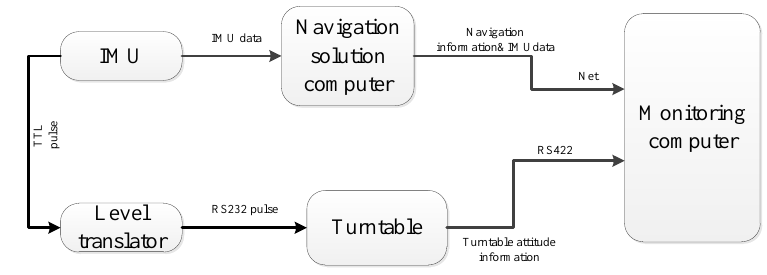
Figure 14. Construction of the navigation